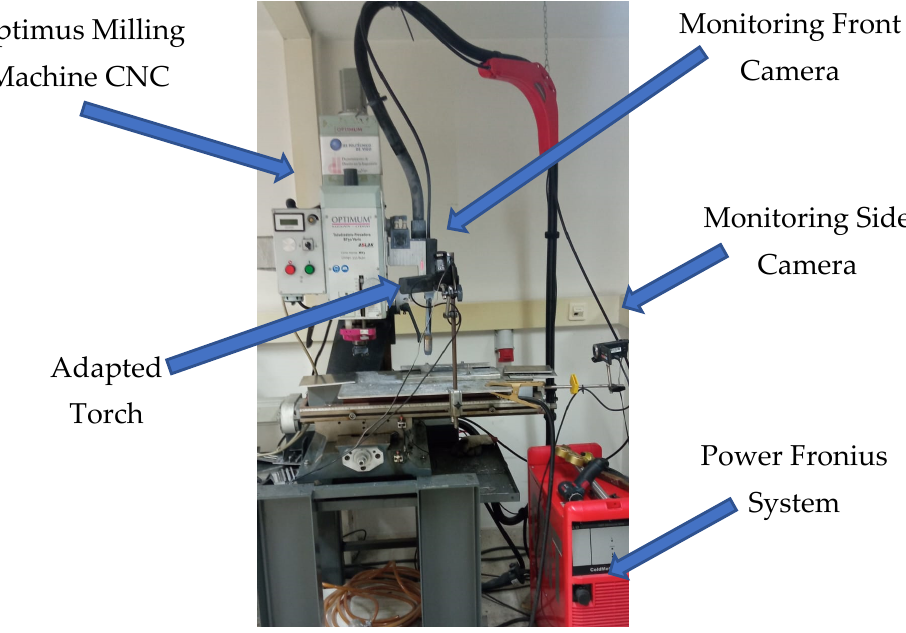
Figure 1. Experimental integration of the CNC systems Optimus CNC and Fronius CMT.